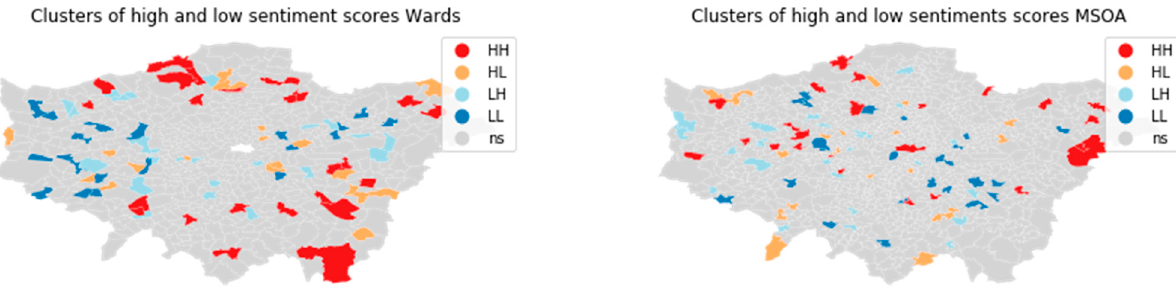
Figure 3. Spatial clusters (local Moran’s I, p < 0.05) of sentiment scores and LOAC diversity.